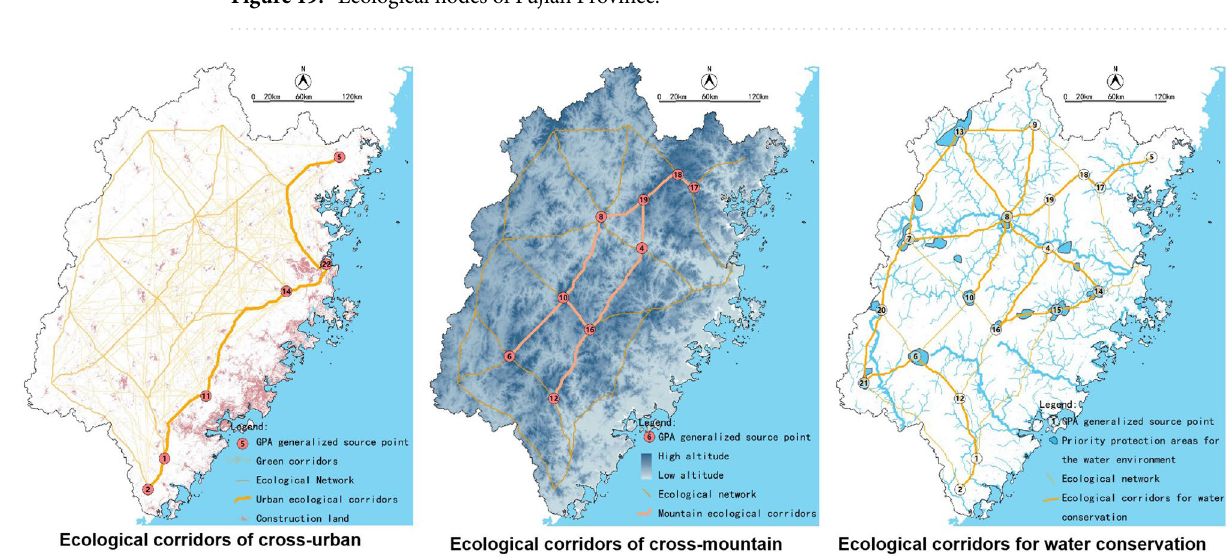
Figure 19. Ecological nodes of Fujian Province.